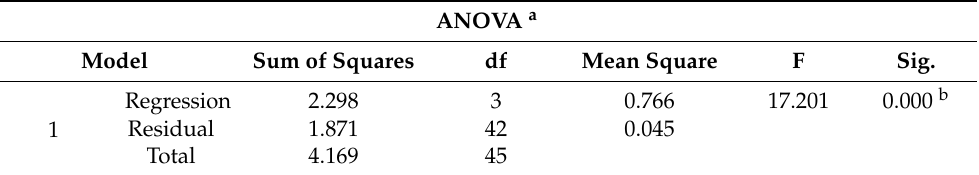
Table 4. Aggregated model parameters.